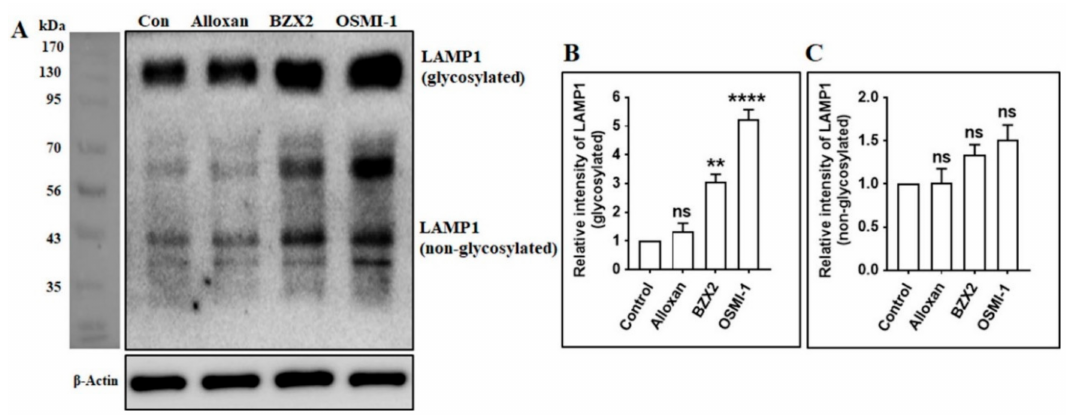
Figure 5. OGT inhibition stimulates the fusion of autophagosomes and lysosomes by inducing LAMP1 expression. ( A ) Cortical neurons were treated with alloxan, BZX2, and OSMI-1 for 24 h. The expression levels of LAMP1 were determined by immunoblot analysis. ( B , C ) Glycosylated and non-glycosylated LAMP1 was determined by densitometry analysis via Image J and presented as mean ± SEM ( n = 3, ** p < 0.01, **** p < 0.0001, ns =